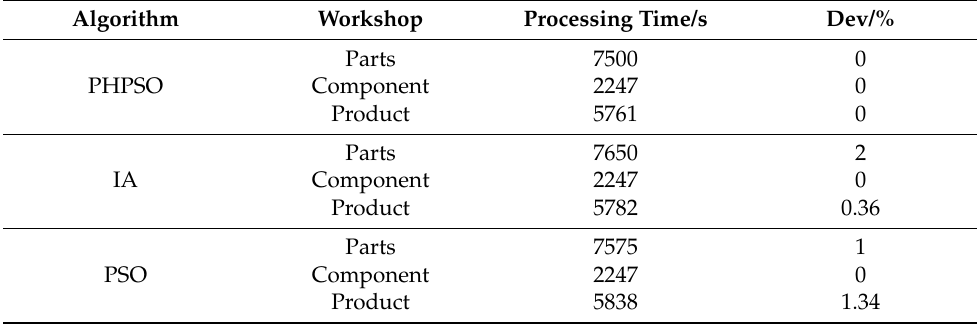
Table 6. Comparison of results.